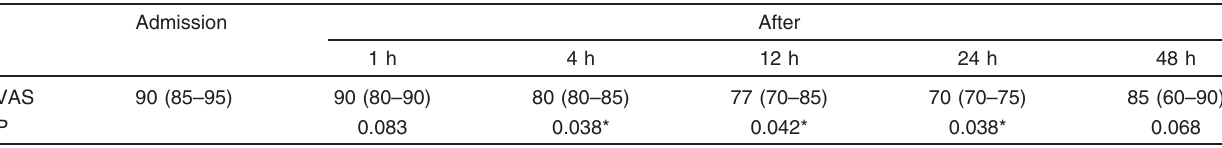
Table 11 Improvement of visual analog score in successful cases of group I ( n = 19) at different studied periods